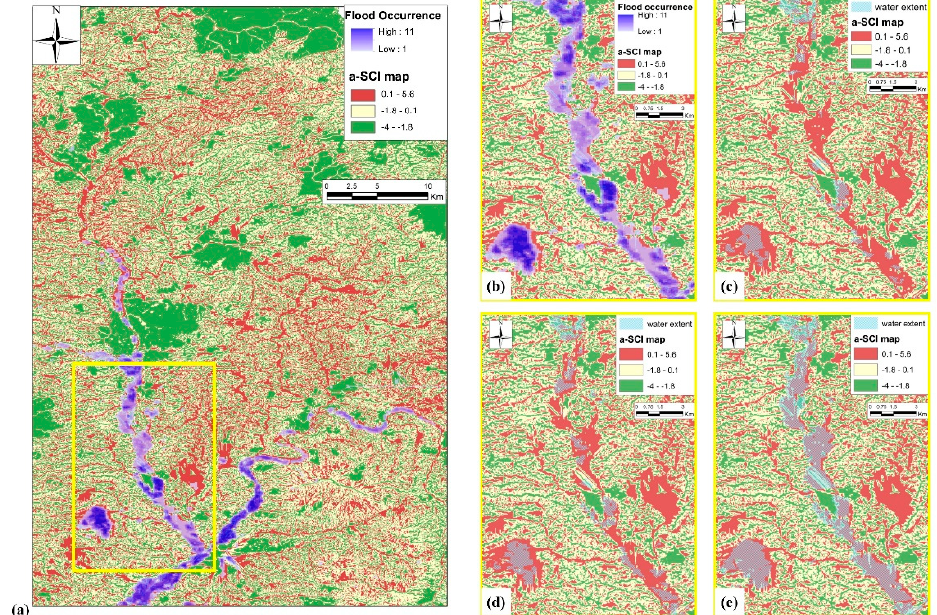
Figure 5. ( a ) a-SCI map and flood occurrence map relative to the 11 flood events considered (different blue gradient regions). ( b – e ) Yellow box in ( a ) shows ( b ) a detailed region with the selected ( c ) minimum, ( d ) medium, and ( e ) maximum water extent for the 11 events with the a-SCI map in background.